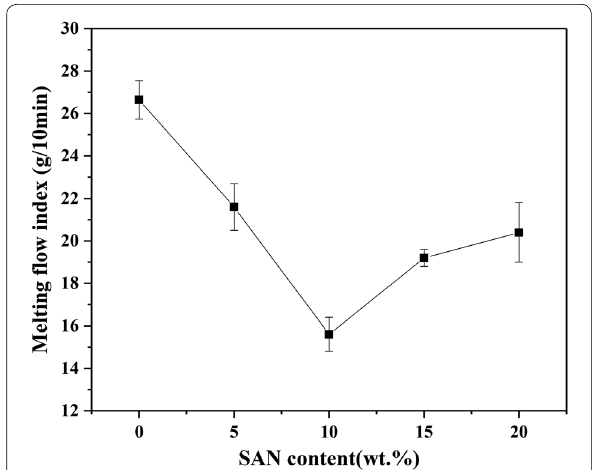
Fig. 5 MFI values of PP and SAN/PP